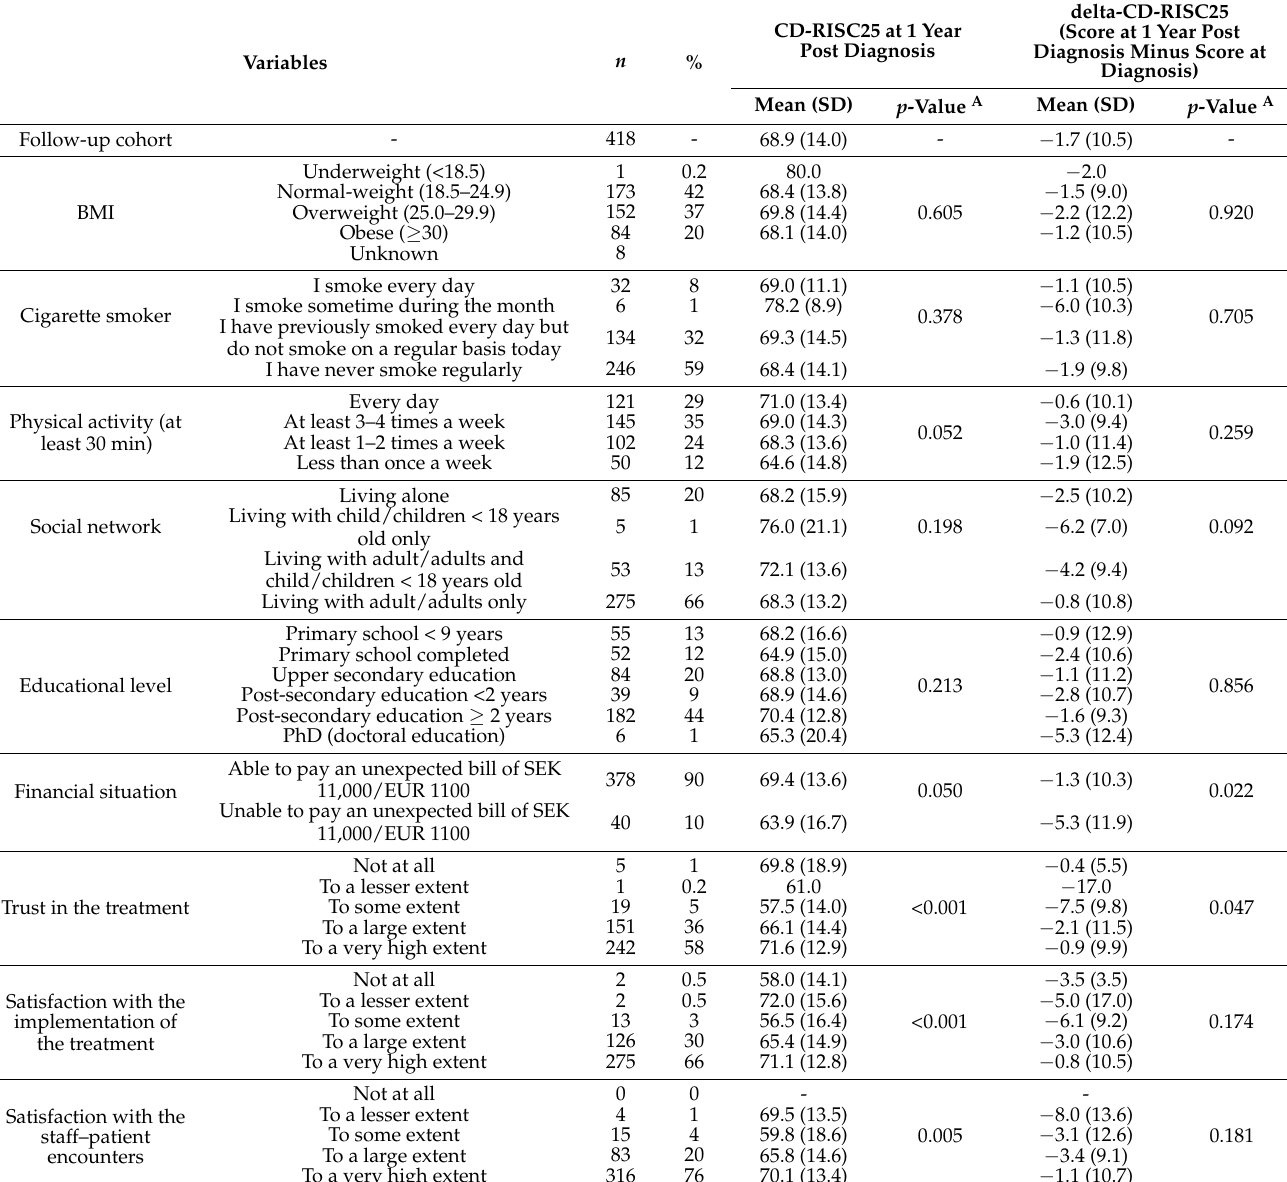
Table 2. Mean score for psychological resilience (CD-RISC25) at 1 year post diagnosis and mean change in psychological resilience score between 1 year post diagnosis and diagnosis (delta-CD-RISC25) according to demographic and study-specific